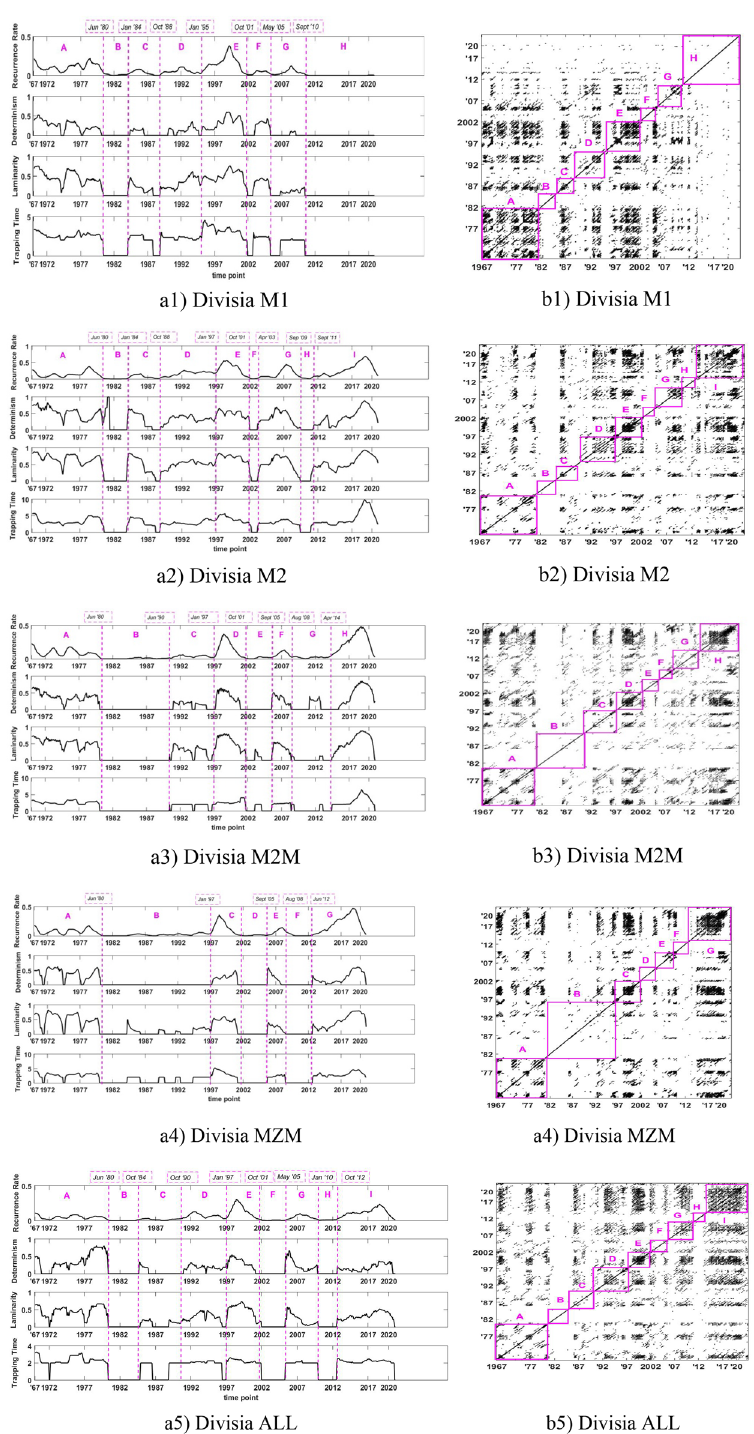
Fig. 5 RQA of the growth rates of narrow Divisia monetary aggregates in Panel ( a ) in 611 quarterly rolling windows (the estimated dates (month/year) of phase transitions are shown on the top) and in Panel ( b ) in their RPs with